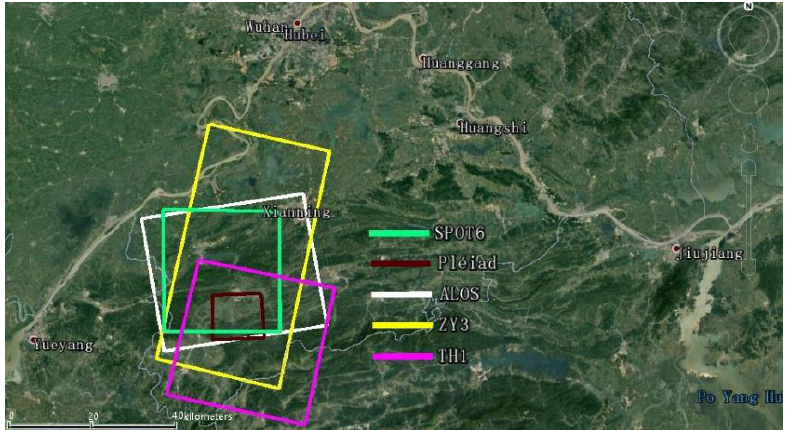
Figure 1. Thumbnail of multiple HRSIs coverage.